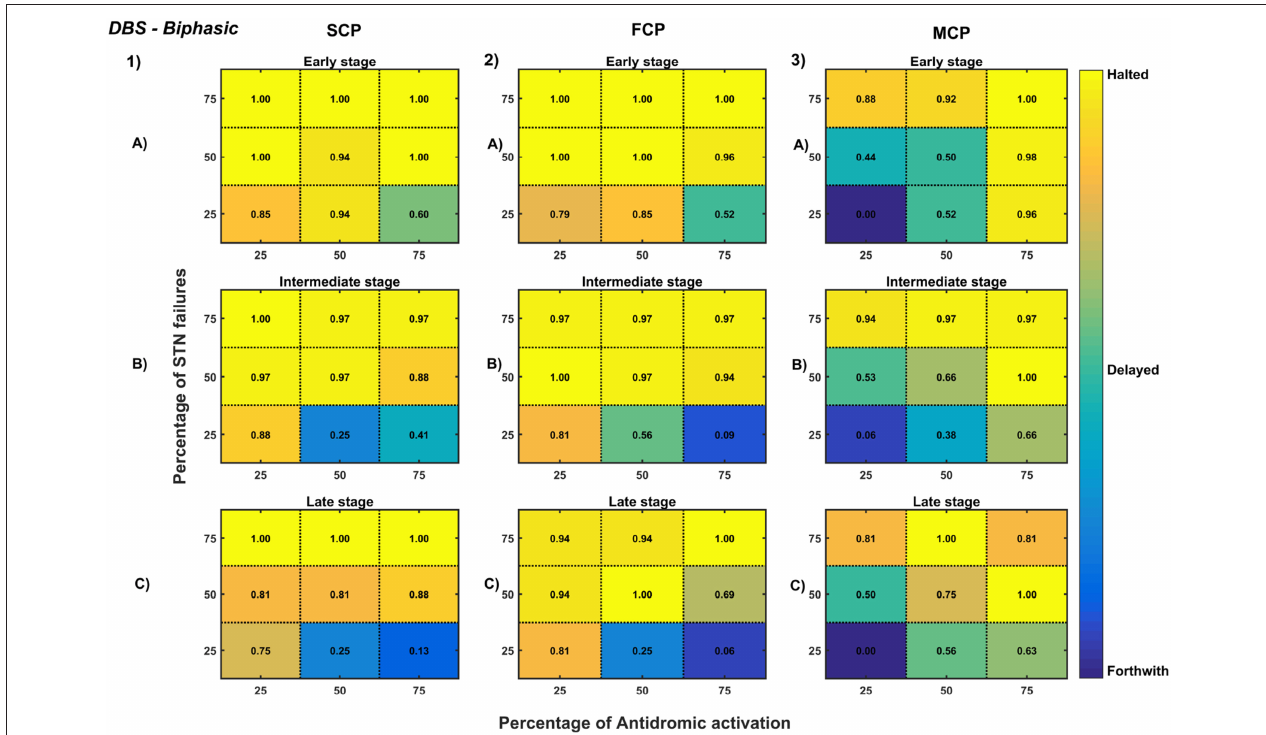
FIGURE 12 | Simulation plots for Biphasic DBS therapy. Profiling of biphasic stimulus waveform for different stimulation configuration in order to achieve the maximal neuroprotective effect of DBS. Confusion matrices for SCP (1) , FCP (2) , and MCP (3) configurations showing survival ratios of SNc cells for different percentage activation of antidromic activation and STN axonal & synaptic failures at early (25%) (A) , intermediate (50%) (B) and late (75%) (C) stages of SNc cell loss. Ratios around 0 is indicated as forthwith (indigo), ratios around 0.5 is indicated as delayed (light green), and ratios around 1 is indicated as halted (yellow). DBS, Deep Brain Stimulation; SNc, Substantia Nigra pars compacta; STN, SubThalamic Nucleus; SCP, Single Contact Point; FCP, Four Contact Point; MCP, Multiple Contact